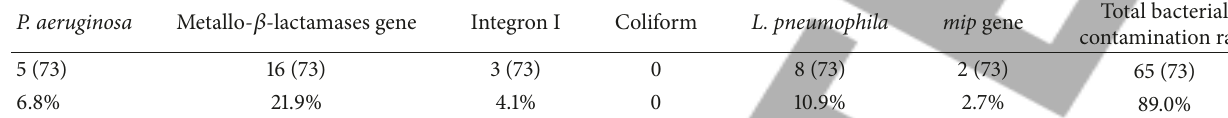
Table 4: Summary of amplification results for incubators water samples.